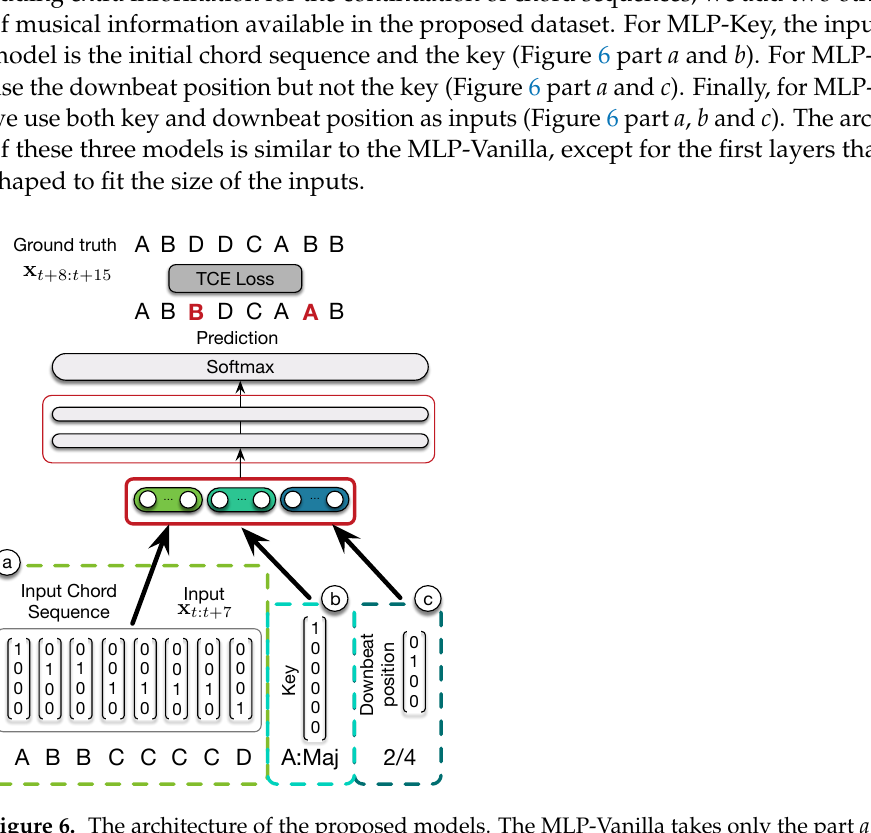
Figure 6. The architecture of the proposed models. The MLP-Vanilla takes only the part a as inputs, the MLP-Key takes the parts a and b , the MLP-Beat takes the parts a and c , the MLP-KeyBeat takes the three parts a , b and c